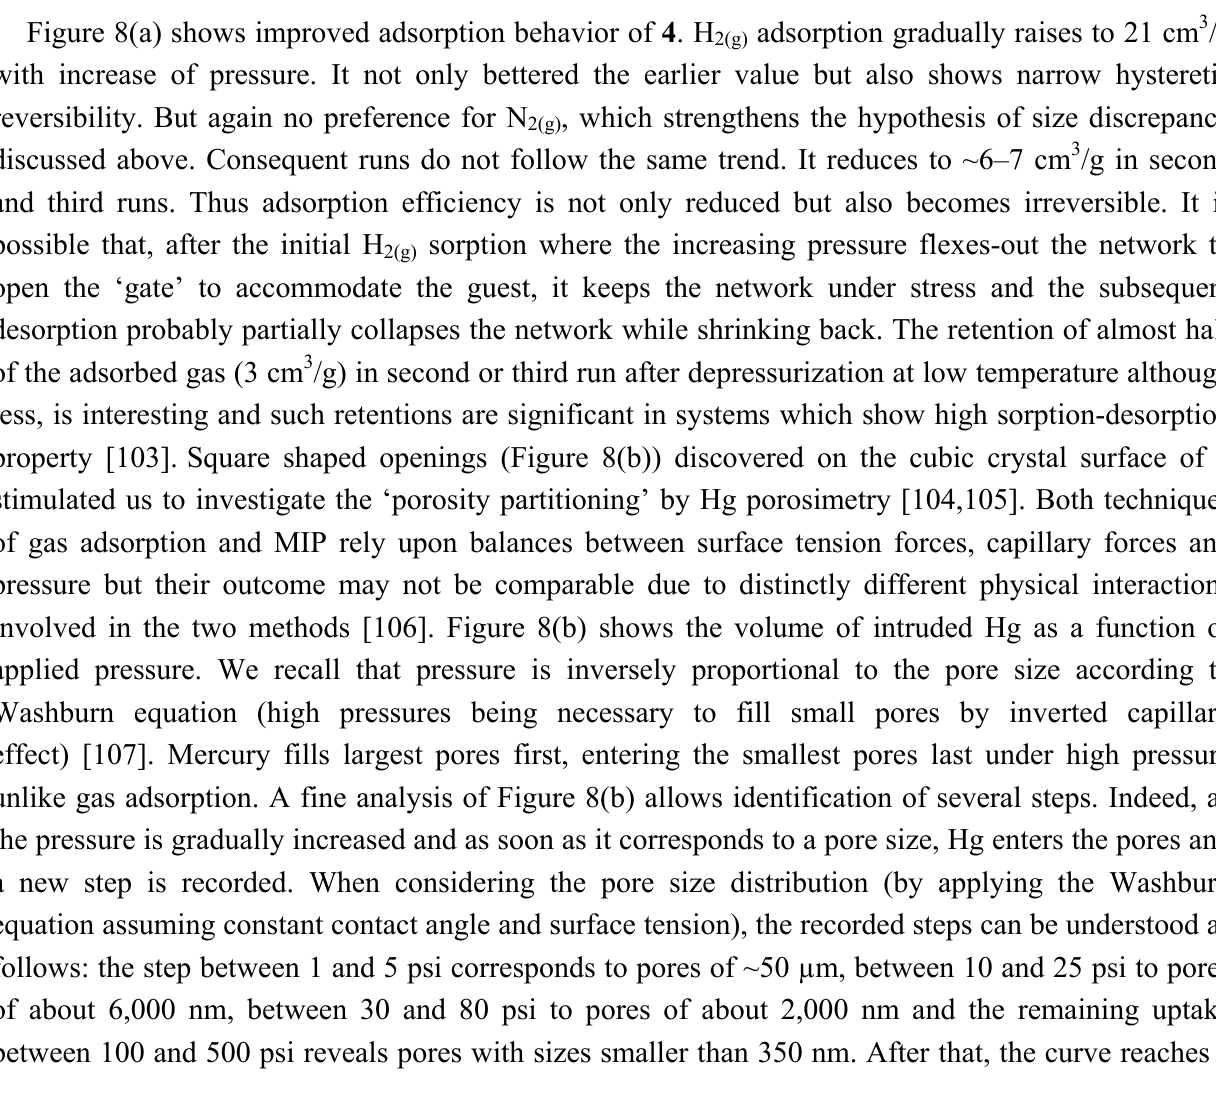
degassed at room 2(g)